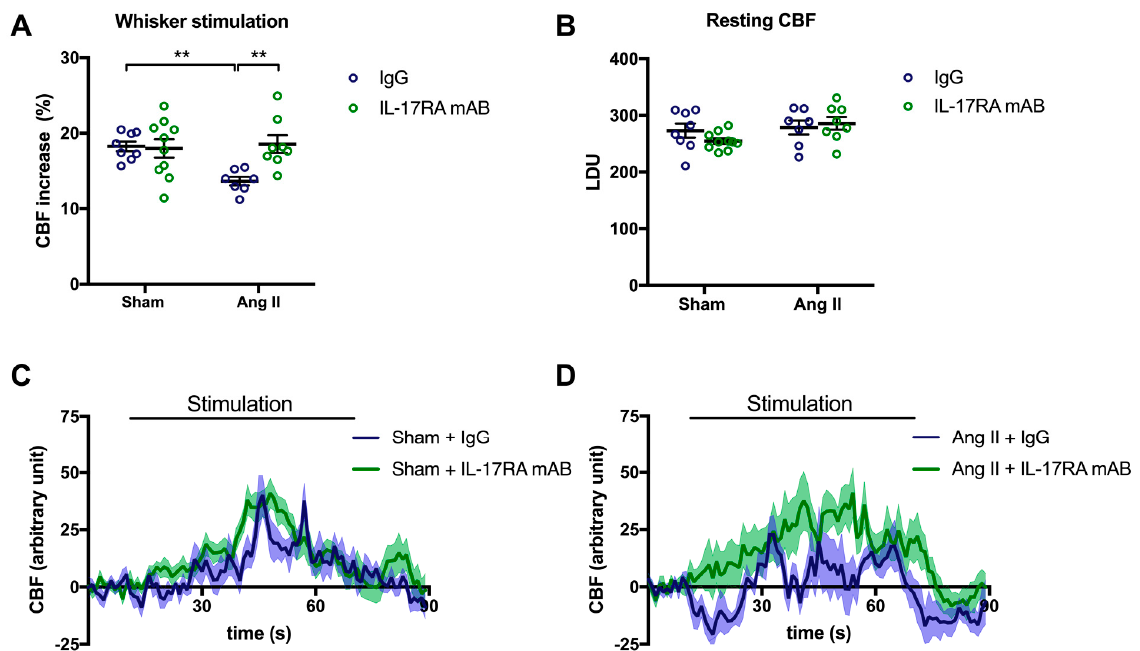
Figure 2. IL-17A receptor inhibition prevents Ang II-induced neurovascular coupling alteration . CBF in response to whiskers stimulations measured in vivo by laser Doppler flowmetry in C57BL/6 male mice treated with an IL-17A receptor antagonist (IL-17RA mAB) or control mouse IgG anti- body (0.5 μ g/ μ L per mouse every 4 days, i.p.). This administration started at day 0 of Ang II (600 ng/kg/min, 14 days) infusion through an osmotic minipump or sham surgery. The graphs depict ( A ) CBF as percentage changes with respect to the initial CBF value, ( B ) resting CBF value as LDU, and ( C , D ) 1 second average curves of the evoked CBF, expressed in arbitrary unit. SEM is repre- sented by the lighter tone shade surrounding each curve. Data were analyzed using an ANOVA for factorial design followed by a Bonferroni post-test. ** p < 0.01 and n = 7–10 per group. 2.2. Neutralization of IL-17A or Inhibition of Its Receptor Prevents the Superoxide Anion Production Induced by Ang II To determine whether the increase in ROS production induced by Ang II is mediated by IL-17A, we investigated whether IL-17A Ab reduces superoxide anion production in- duced by Ang II. As shown in Figure 3, the increased production of superoxide anion by Ang II seen in the somatosensory cortex ( p = 0.079) and in the hippocampus ( p < 0.0001) was prevented following IL-17A Ab administration.